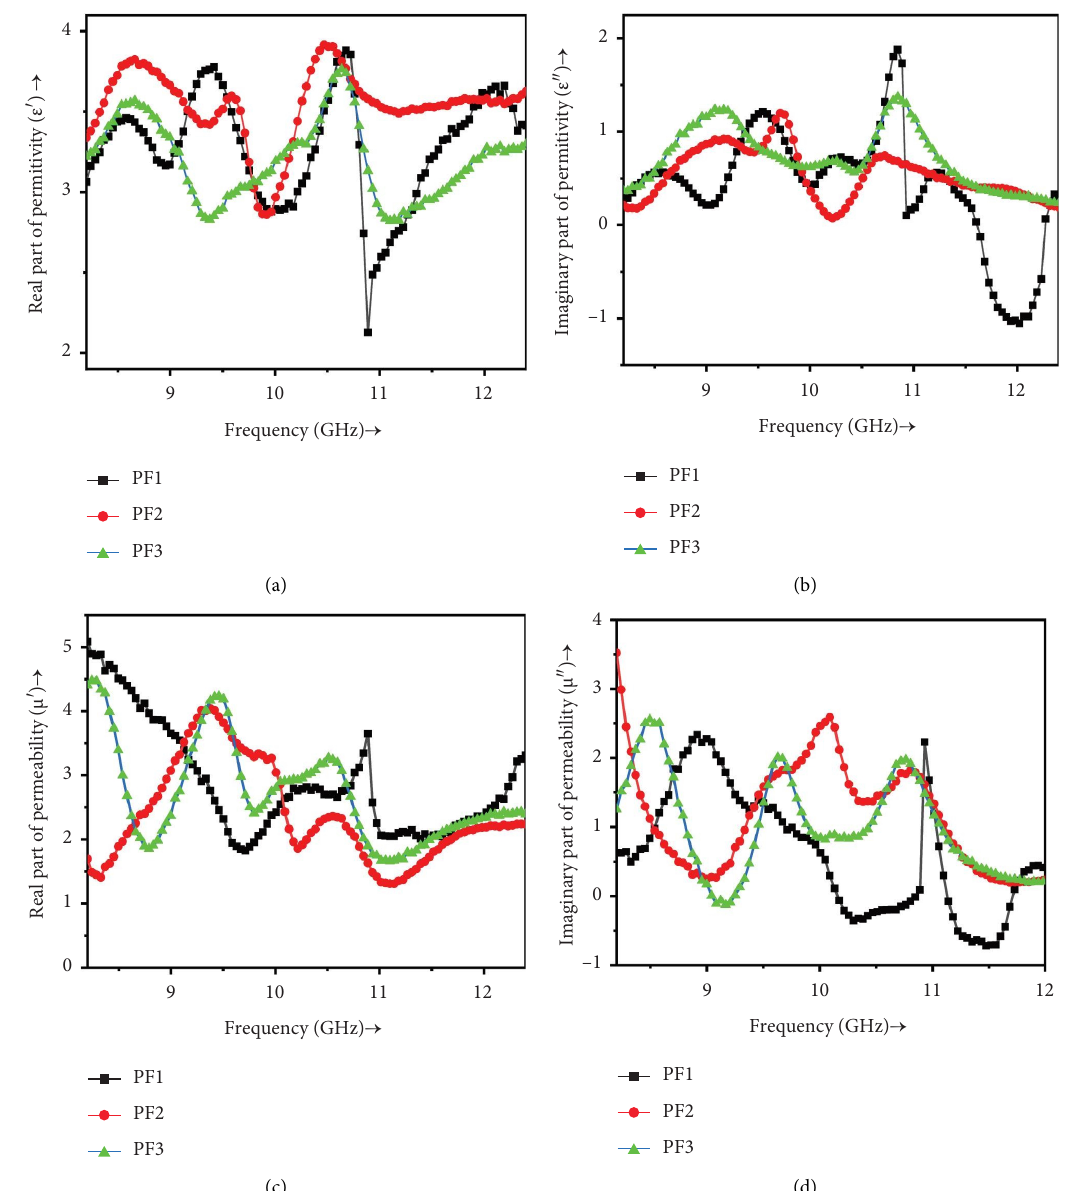
Figure 16: Complex dielectric permittivity (a) real ( ε (d) imaginary ( μ r ″ ) of PF1, PF2, and PF3